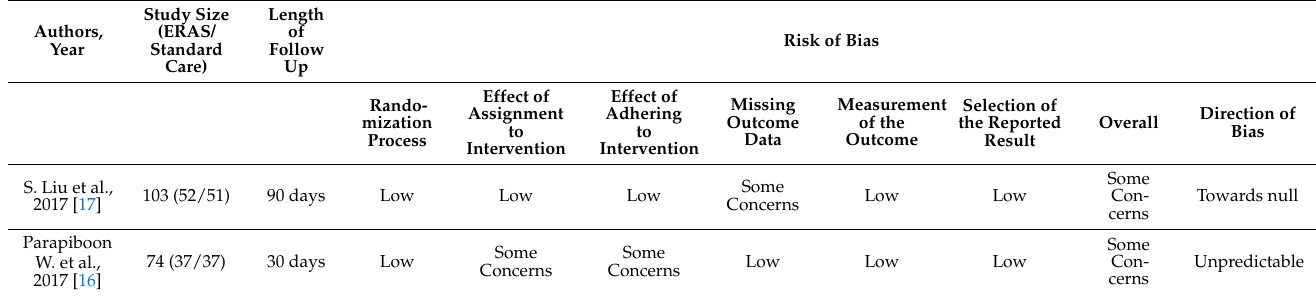
Table 2. Randomized clinical trials: quality and risk-of-bias